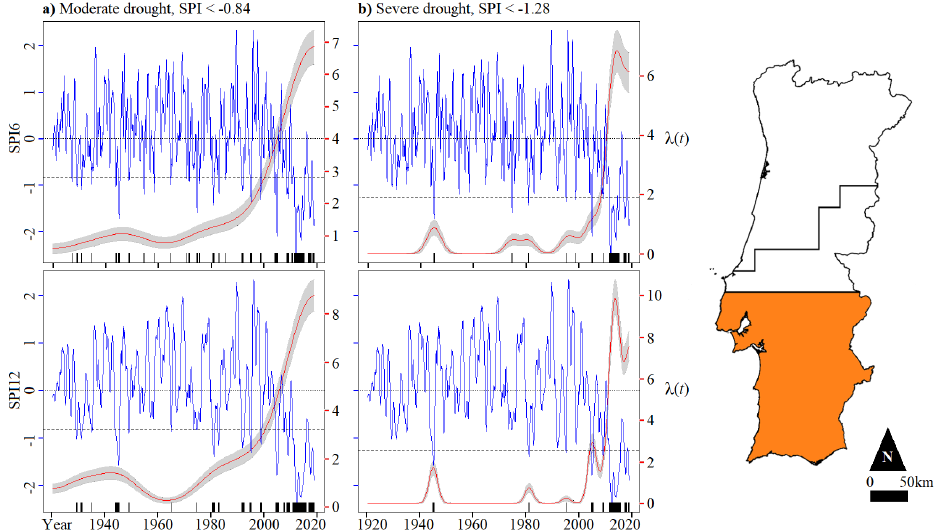
Figure 11. Southern region. Time dependent occurrence rates, λ ( t ) (year − 1 ), in red, and confidence band in grey of ( a ) moderate and ( b ) severe droughts for SPI6 and SPI12 in blue. The horizontal- dashed lines different to zero represent the drought thresholds and vertical ticks, with SPI below